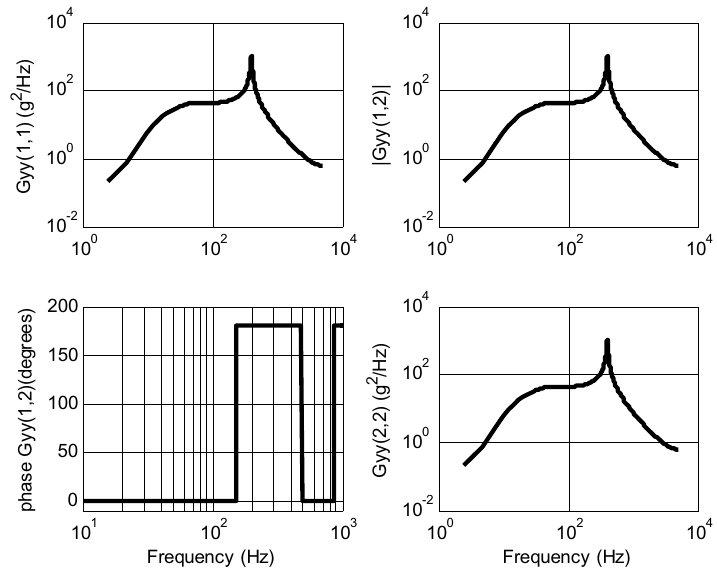
Fig. 24. Example 4, Magnitude of the Fourier spectra of the outputs, scaled as power spectra.